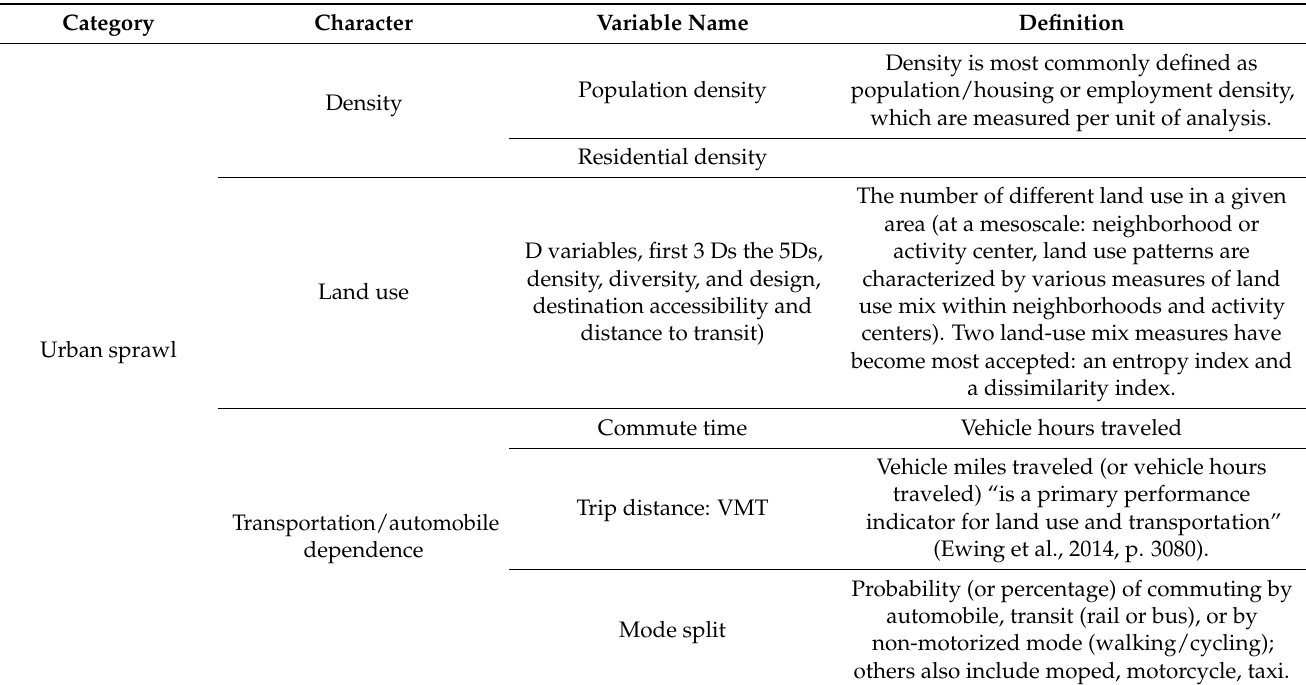
Table 3. Sets of variables are used to measure